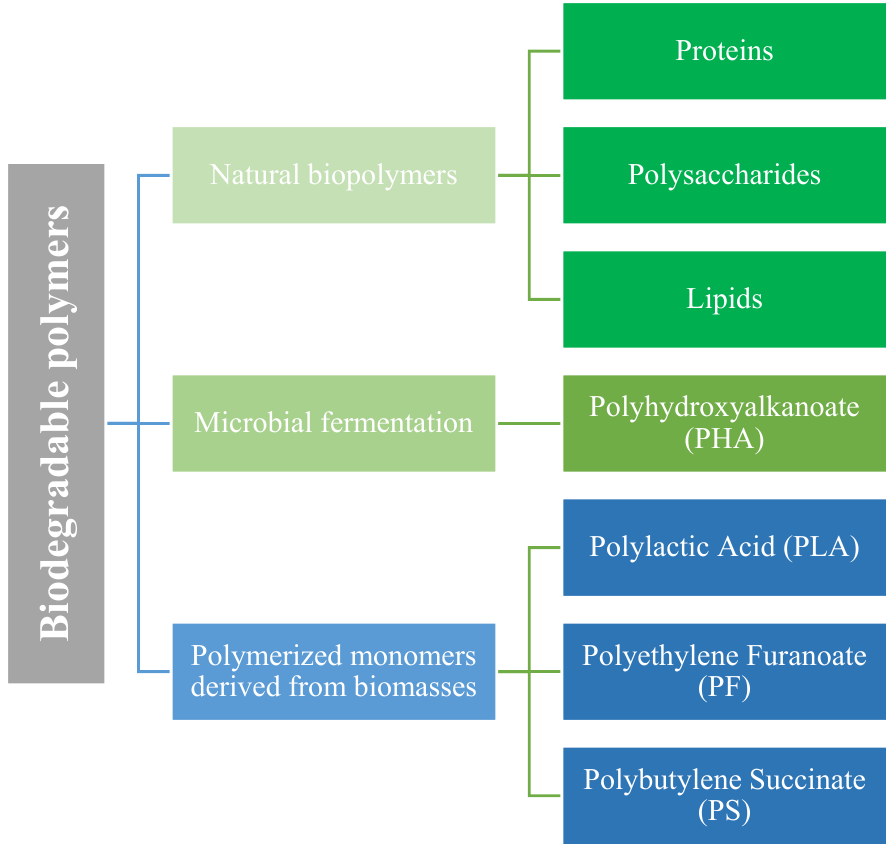
Figure 1. Biodegradable polymers from different sources.